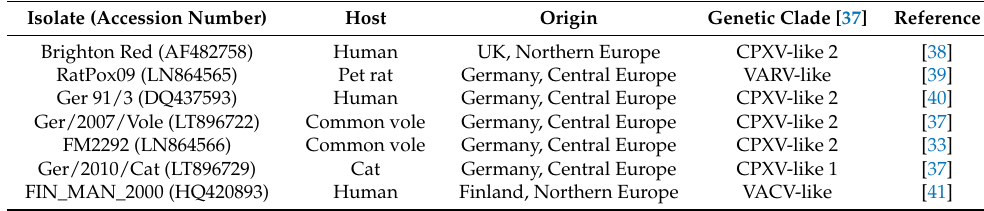
Table 1. Characterization of CPXV strains used for experimental